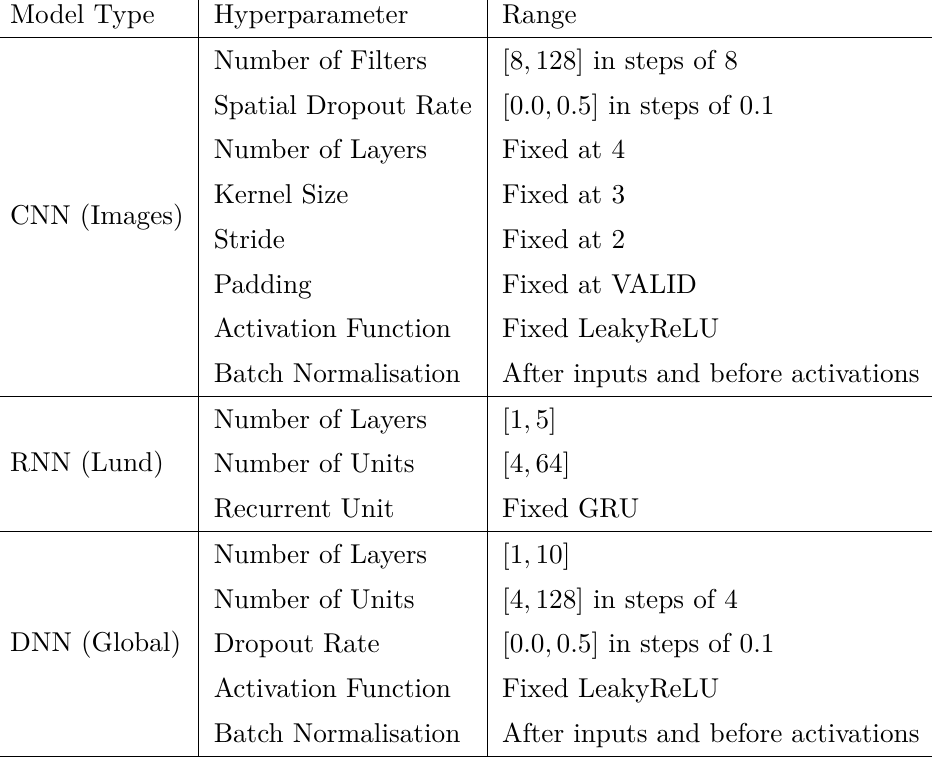
Table 1 . Hyperparameter search spaces for the different Deep Learning architecture